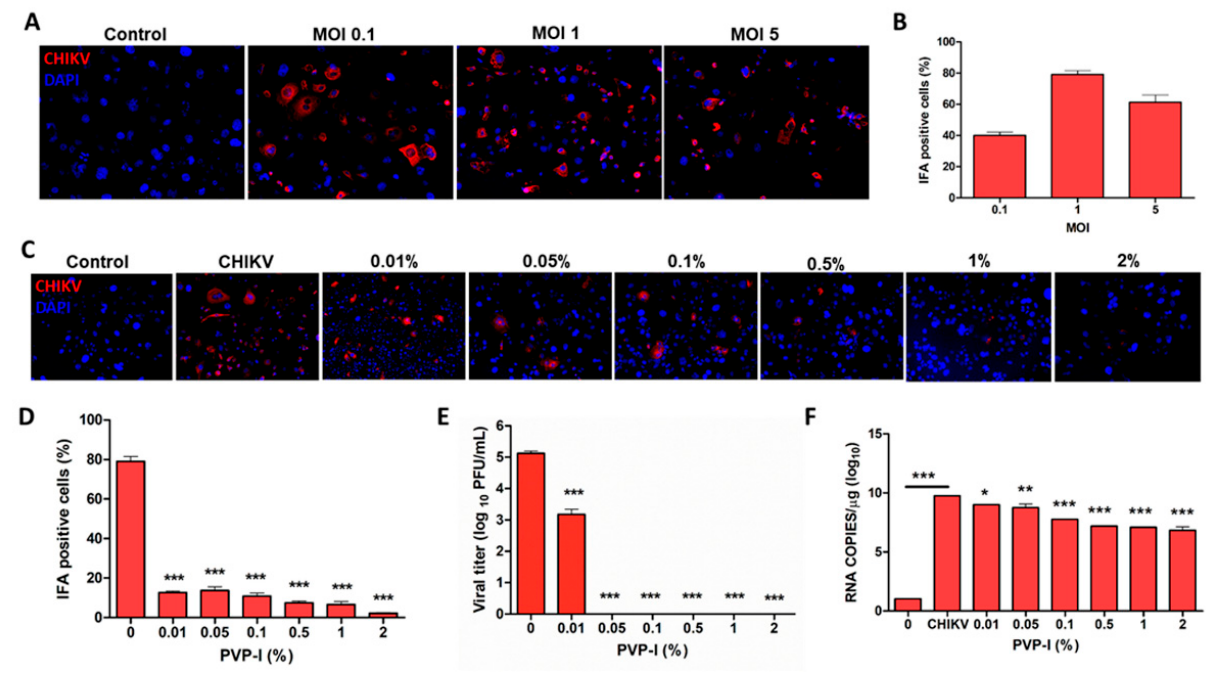
Figure 3. Corneal epithelial cells are permissive to CHIKV infection and PVP-I exposure attenuates viral replication. Human corneal epithelial cells (HUCL cell line) seeded on lab-tek chamber slides were infected with CHIKV at different MOIs (0.1, 1 and 5) for 12 h followed by immunofluorescence staining ( A ) and quantitation of viral antigen-positive cells ( B ). In another experiment 12 h CHIKV-infected (MOI 0.1) HUCL cells were incubated with varying concentrations of PVP-I for one minute. After PVP-I exposure, cells were rinsed and allowed to grow for 24 h in a fresh medium. Viral replication was determined by immunofluorescence staining ( C ) and quantification of CHIKV antigen-positive cells ( D ) , plaque assay ( E ), and assessment of viral RNA copy number by qPCR ( F ). One-way ANOVA Dunnett’s test was used for statistical analysis wherein, *** p < 0.001; ** p < 0.01, * p < 0.05.